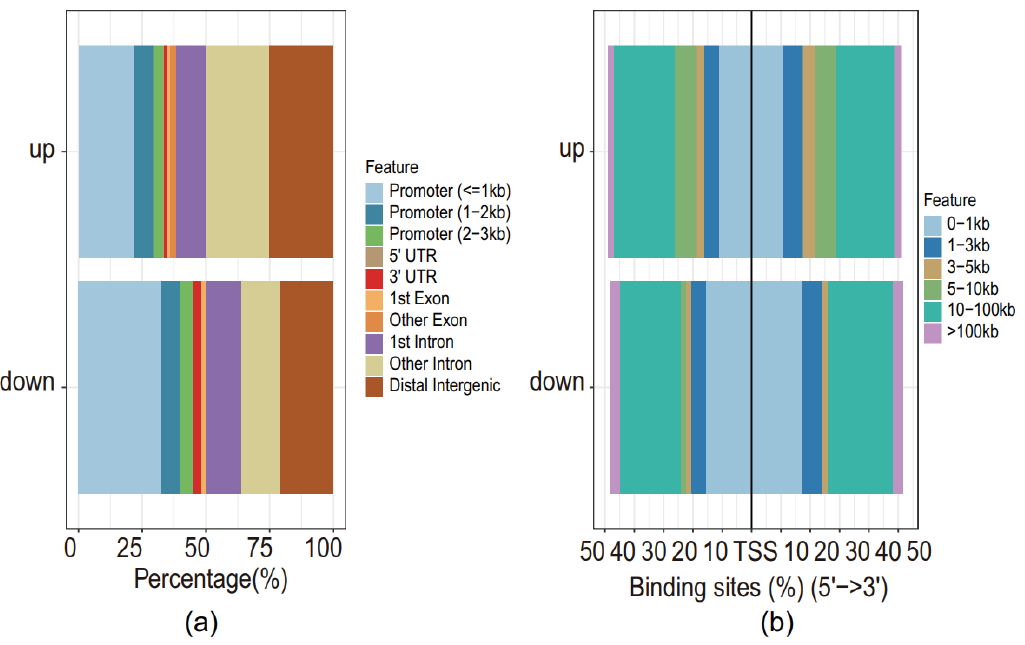
Figure 2. Genomic locations of the differentially expressed peaks. ( a ) Proportions of genomic locations. UTR stands for the untranslated region. ( b ) Proportions of peak-to-TSS distances.